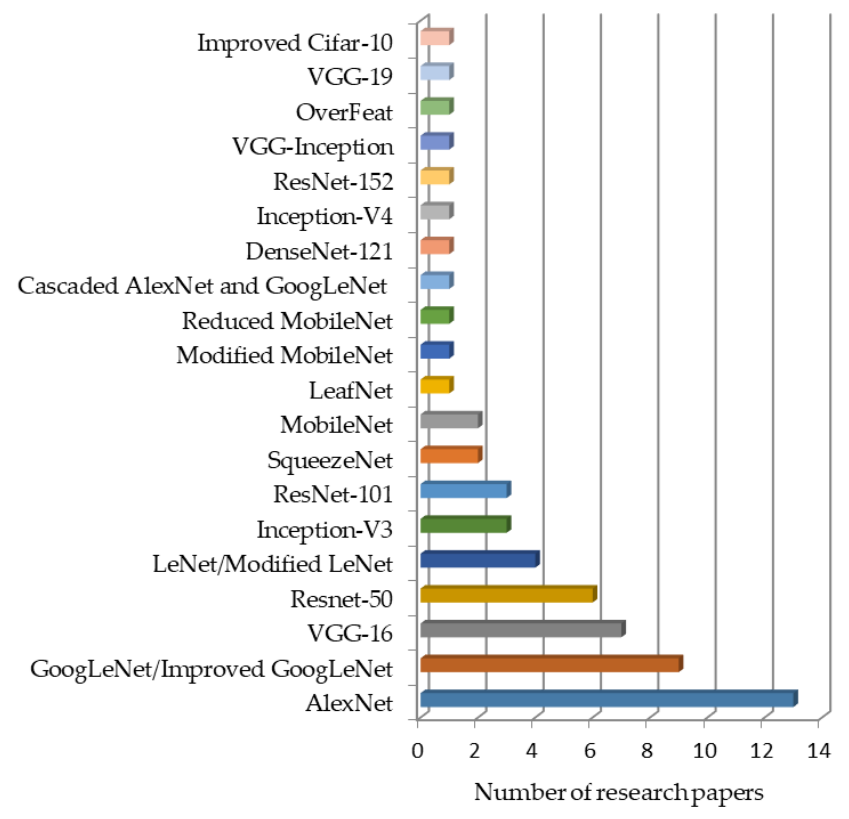
Figure 12. Deep learning models used in the particular number of research papers.